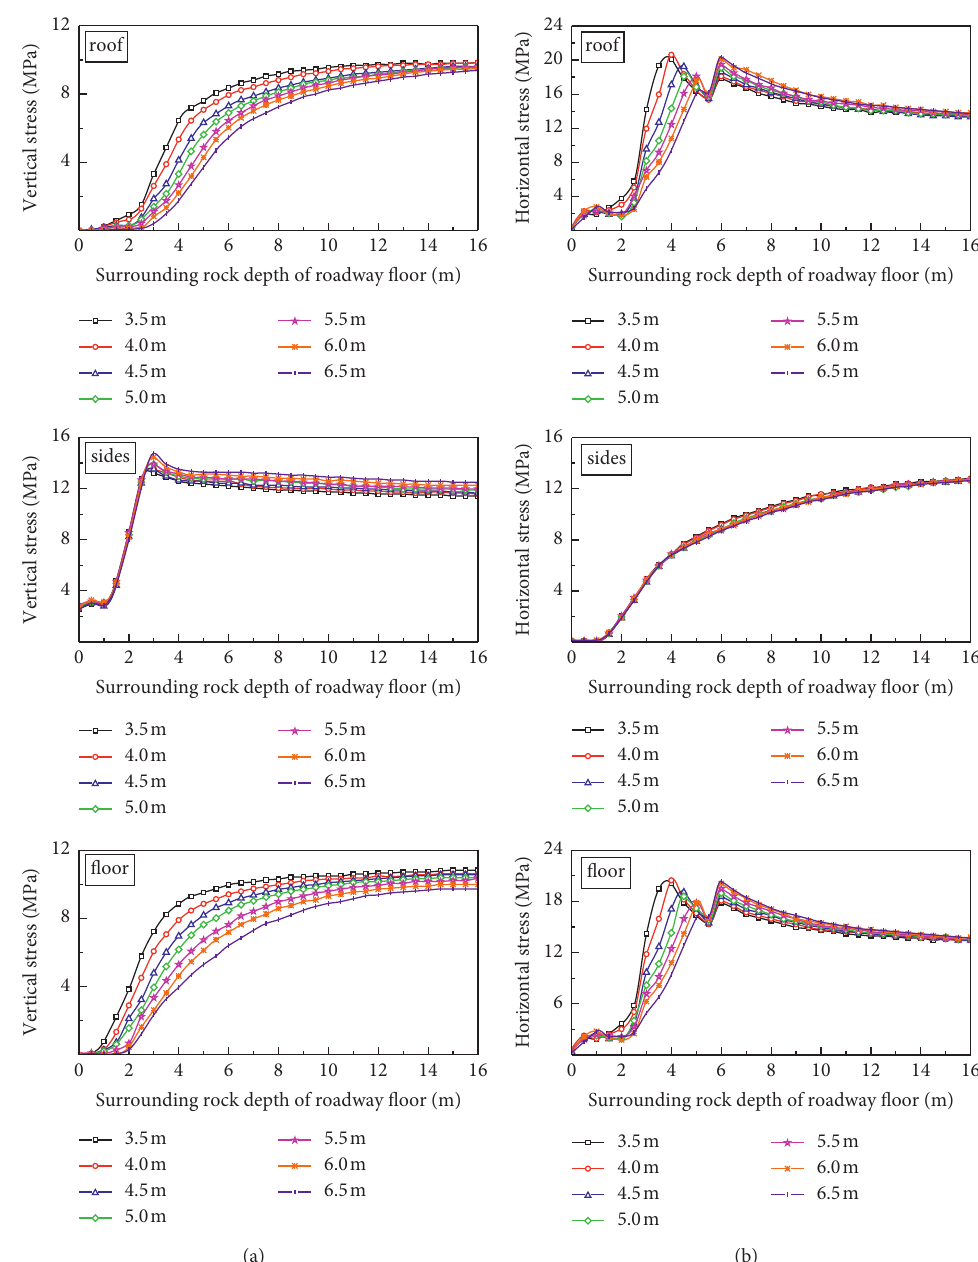
Figure 9: Influence of roadway width on surrounding rock stress. (a) Vertical stress; (b) horizontal